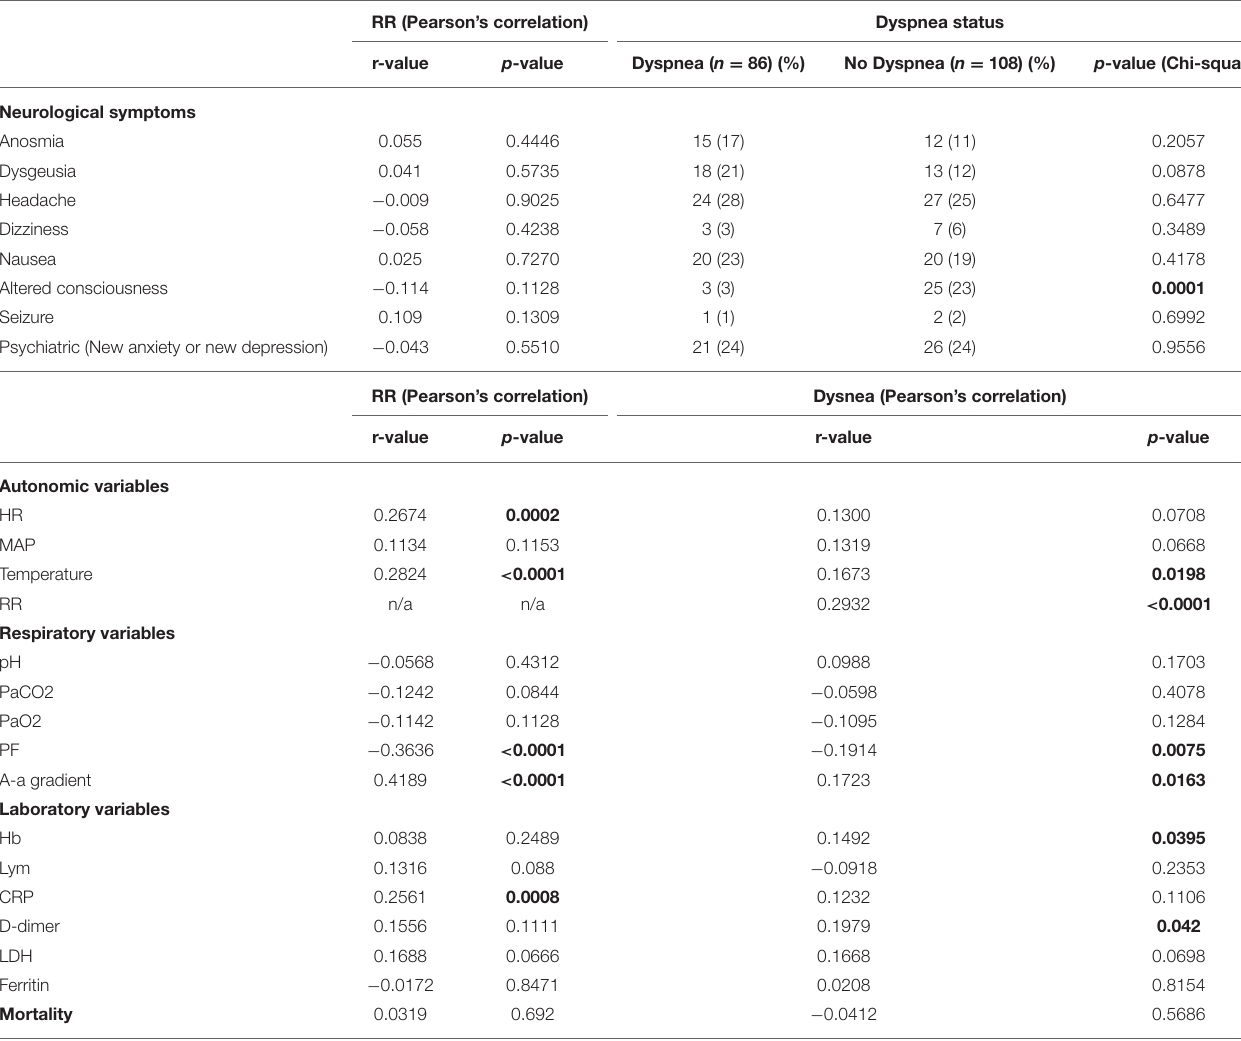
TABLE 1 | Relationship between neurological, autonomic, biochemical variables and RR and dyspnea. RR (Pearson’s